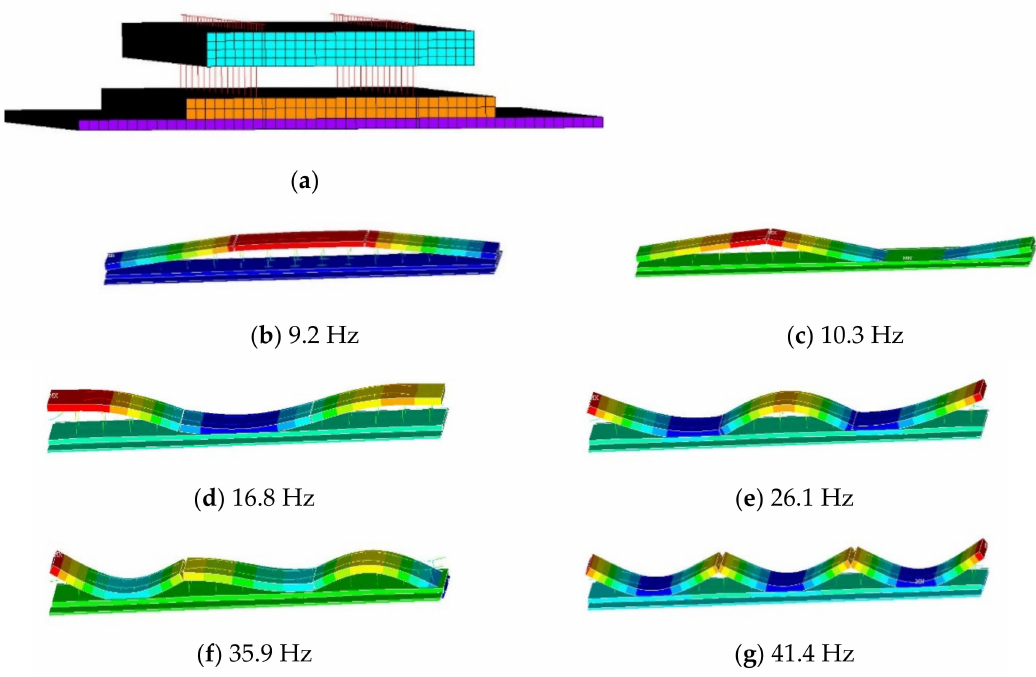
Figure 17. Finite element model ( a ) and the first modes ( b–g ) of the floating-slab track on steel spring viscous dampers with three 6 m long